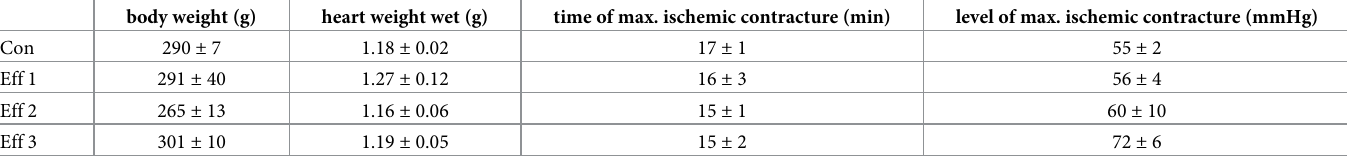
Table 1. Weights and ischemic